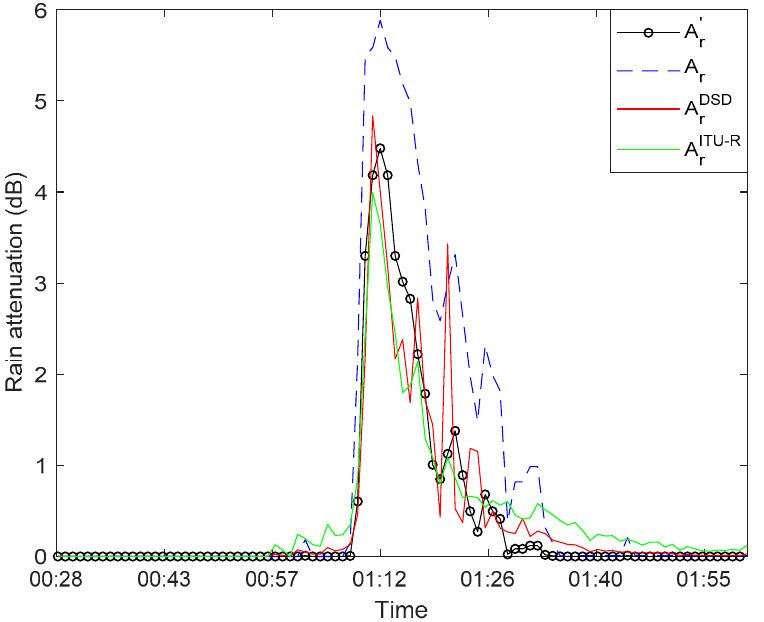
Figure 6. Curve fitting of